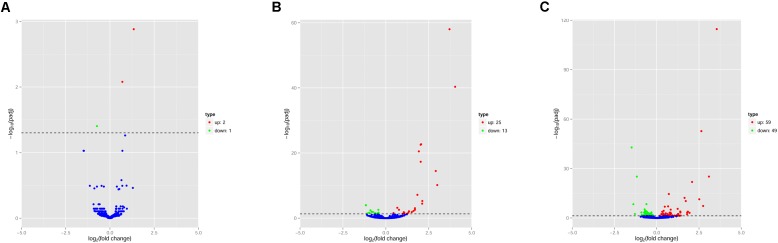
Volcano plots of miRNA expression changes in the mouse brain. Differentially expressed miRNAs (P < 0.05) in (A) “acute vs uninfected,” (B) “chronic vs. uninfected” and (C) “chronic vs. acute.” Red, green and blue dots represent upregulated, downregulated and non-regulated miRNAs, respectively. The x-axis represents the log2 ratio of gene expression levels between mouse groups. The y-axis is adjusted p- based on -log10.